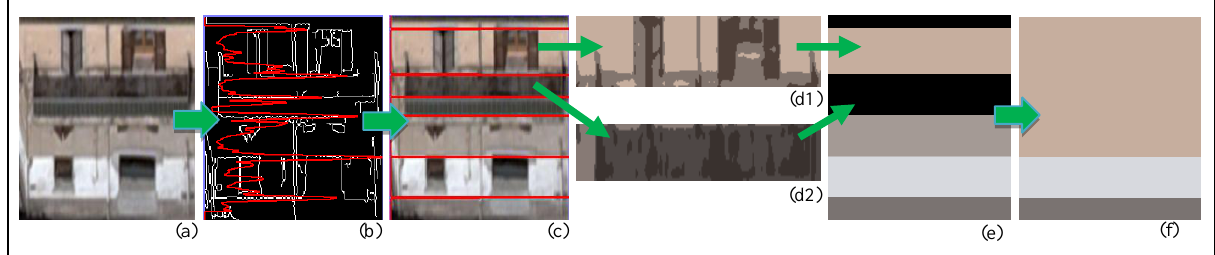
Figure 6. Façade principal colours: the gradient image (b) is stacked horizontally giving peaks allowing slices cutting (c). The number of colour is reduced (d) and the distribution of colour patches analysed to find the façade colour (d1) or set it to undef if too scrappy (d2). Missing colours are deduced from neighbouring slices and close colours merged to give the final image (f) If the slice's patches are too scrappy the façade colour is set to step is performed to complete these undefined colours. The